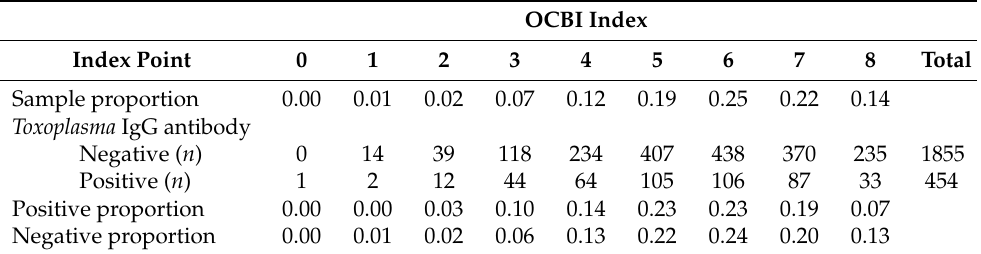
Table 7. Overall index of cardiovascular biomarkers (OCBI).